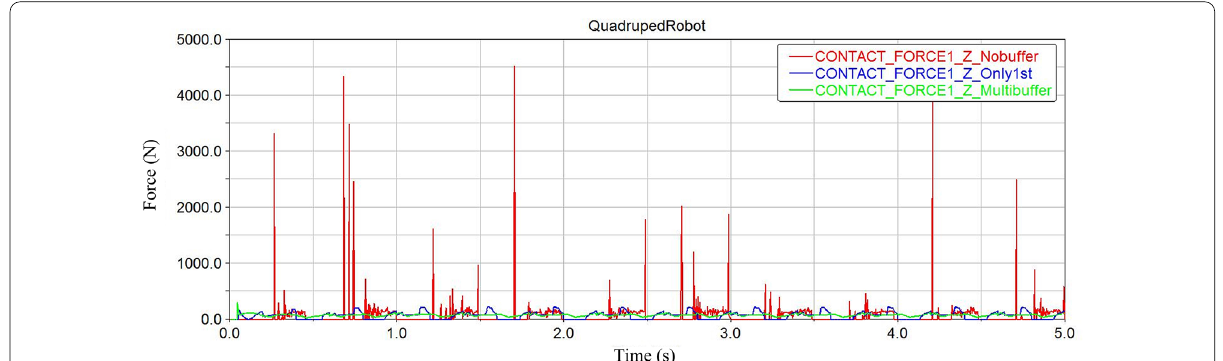
Figure 27 Contact force variation comparison of the three